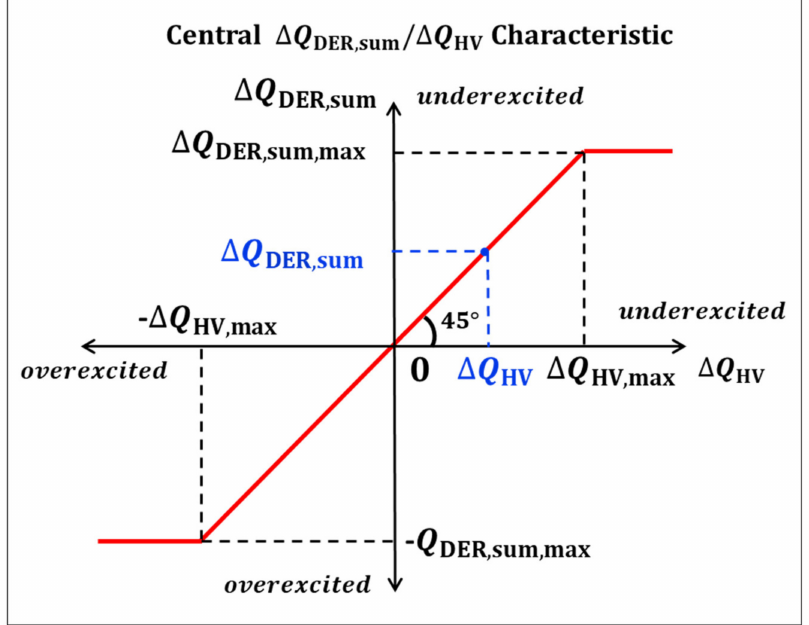
Figure 3. Central ∆ Q DER,sum / ∆ Q HV fPV generation and low load consuption HV curve for Q management at 110